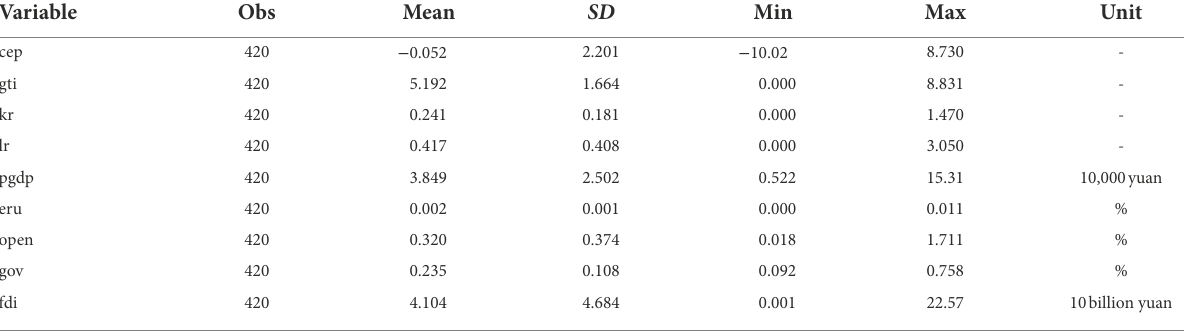
TABLE 1 The statistical description of variables. Variable